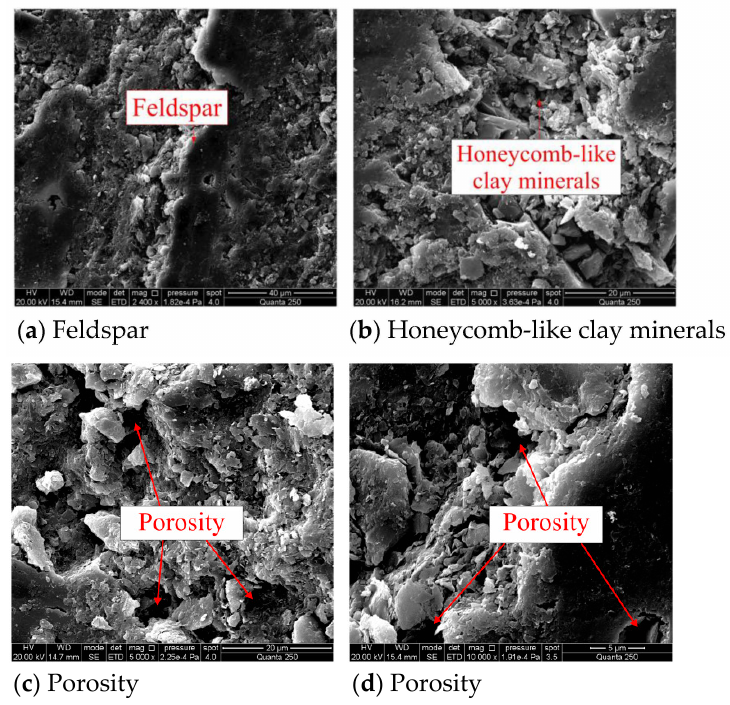
Figure 9. SEM photomicrographs of mudstone.